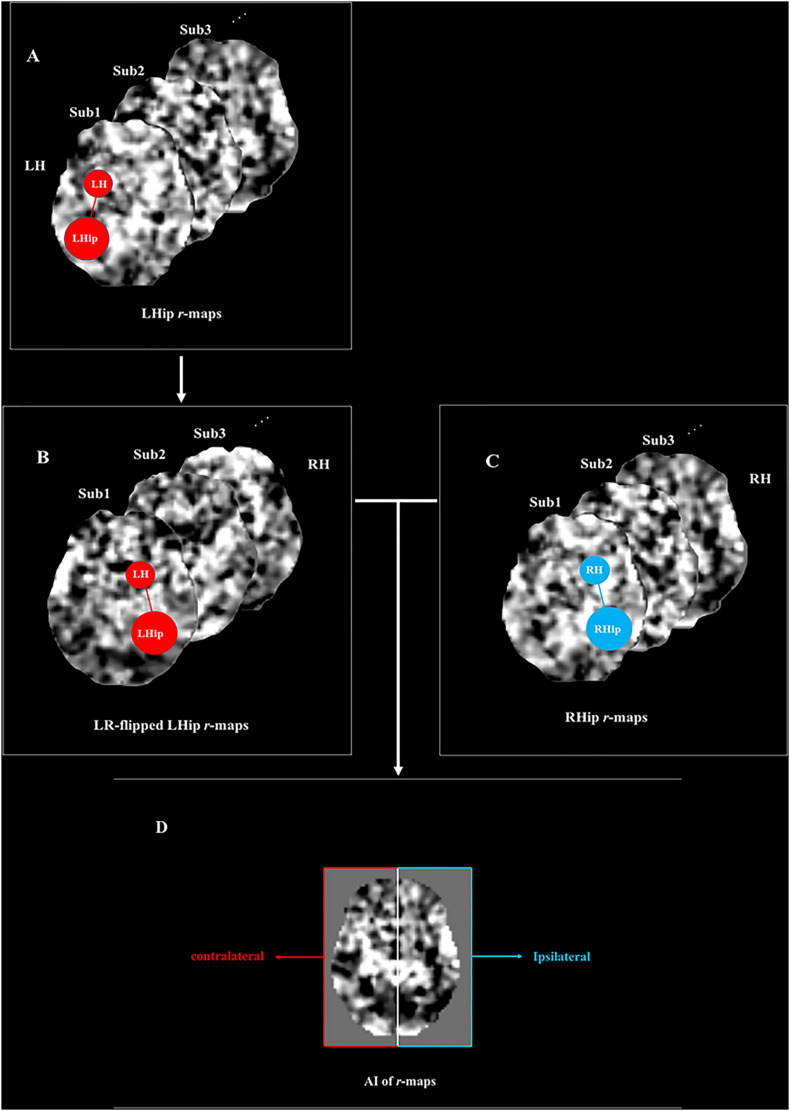
The diagram of asymmetry index (AI) calculates the function connectivity (FC) between the hippocampus and insula. (A) Individual left hippocampus r-maps (L-r maps). The schema on the first r-map represented the functional connectivity of the left hippocampus with the brain regions in the left hemisphere (i.e., LHip—LH). (B) LR-flipped left hippocampus r-maps (LR-r maps). As indicated by the schema, the connectivity of the left hippocampus with its ipsilateral brain regions was flipped to the right side and the connectivity of the left hippocampus with its contralateral brain regions was flipped to the left side. (C) Individual right hippocampus r-maps (R-r maps). The schema represents the functional connectivity of the right hippocampus with the brain regions in the right hemisphere (i.e., RHip—RH) (D) Individual AI(r) maps were calculated by the formulation. The formulation equaled (R-r maps - LR-r maps)/(R-r maps + LR-r maps). The right side of the AI(r) map represented the asymmetry of functional connectivity of the hippocampus with its ipsilateral hemisphere (i.e., RHip—RH vs LHip—LH), and the left side of the AI(r) map represented the asymmetry of functional connectivity of the amygdala with its contralateral hemisphere (i.e., RHip—LH vs LHip—RH). The positive value of the AI(r) map represented a rightward asymmetry which meant the connectivity of right hippocampus with such region was greater than the connectivity of left hippocampus with its counterpart. On the other hand, the negative value of the AI(r) map represented a left asymmetry, which meant that the connectivity of the left hippocampus with such region was greater than the connectivity of the right hippocampus with its counterpart. LHip, left hippocampus; RHip, right hippocampus; LH, left hemisphere; RH, right hemisphere. The figure was adapted from Yan et al. (2009).